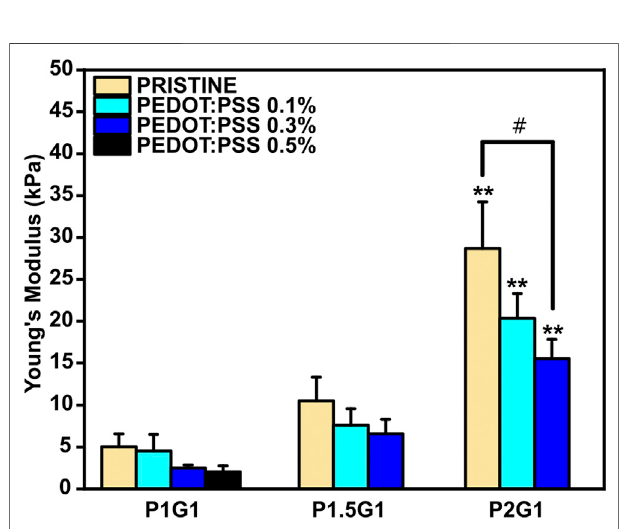
FIGURE 5 | Compressive Young ’ s Modulus of pristine and doped hydrogels with varying PEGDA:gelatin ratios and PEDOT:PSS contents. ** p < 0.01 represent signi fi cative differences in respect to P1G1 and P1.5G1 samples. # p < 0.05 represent signi fi cative differences for all other